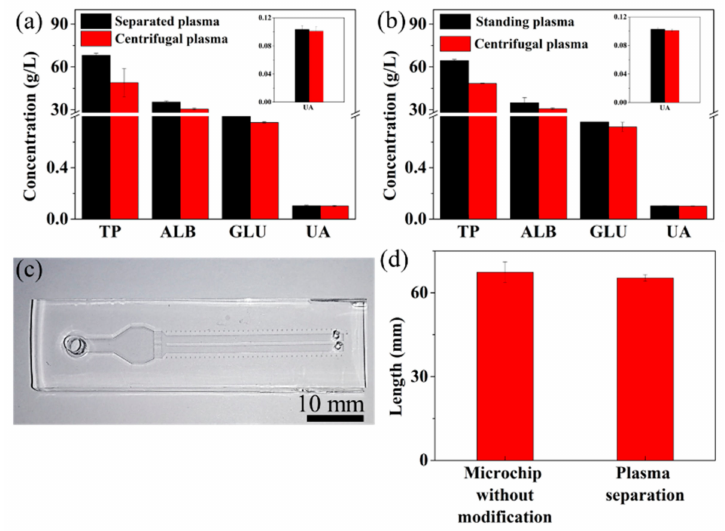
Figure 4. ( a ) Component concentrations of the separated and centrifugal plasma samples; inset is the UA concentration of separated and centrifugal plasma samples. ( b ) Absorbance of standing and centrifugal plasma; inset is the UA concentration of separated and centrifugal plasma samples. ( c ) The photo of the microdevice for the study of the effect of microsphere barrier on the measurement results. ( d ) The length of water separated from the